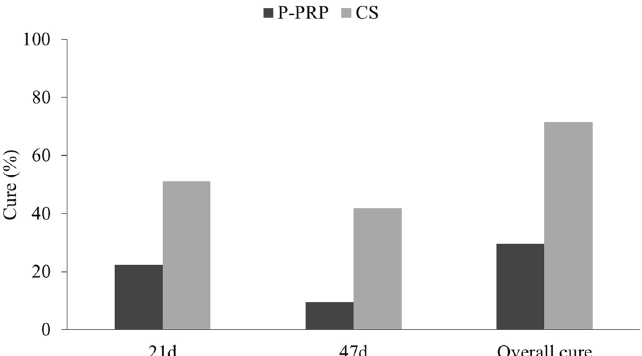
Figure 4. Bacteriological cure rate at 21 days and 47 days, and the overall cure rate in cows with subclinical mastitis caused by Gram-positive major pathogens following intramammary treatment with 10 mL of P-PRP (pure platelet rich plasma) or 75 mg of CS (cefquinome sulfate) over three consecutive